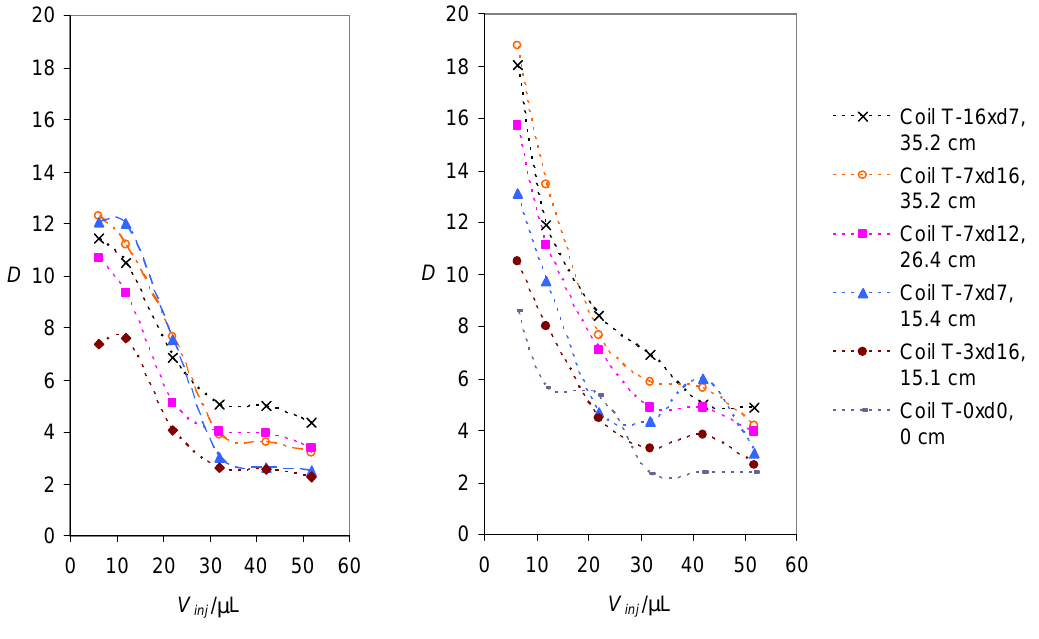
Figure 8. Dispersion coefficients obtained for different dye-injection volumes and mixing-coil lengths and geometries at the flow rates 1.5 ml/min (left) and 0.5 ml/min